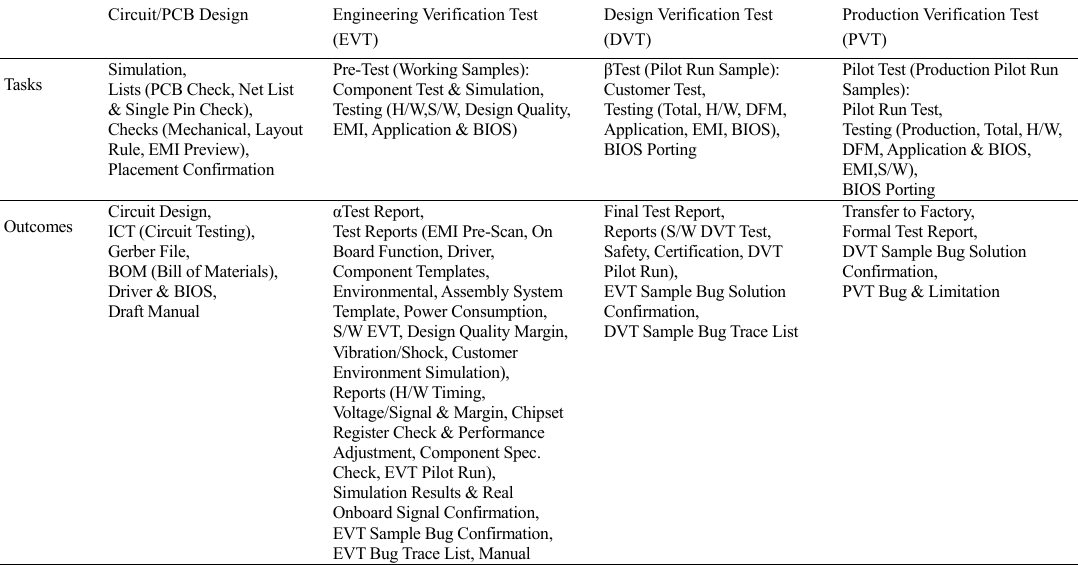
Table 1. Brief description of design and test